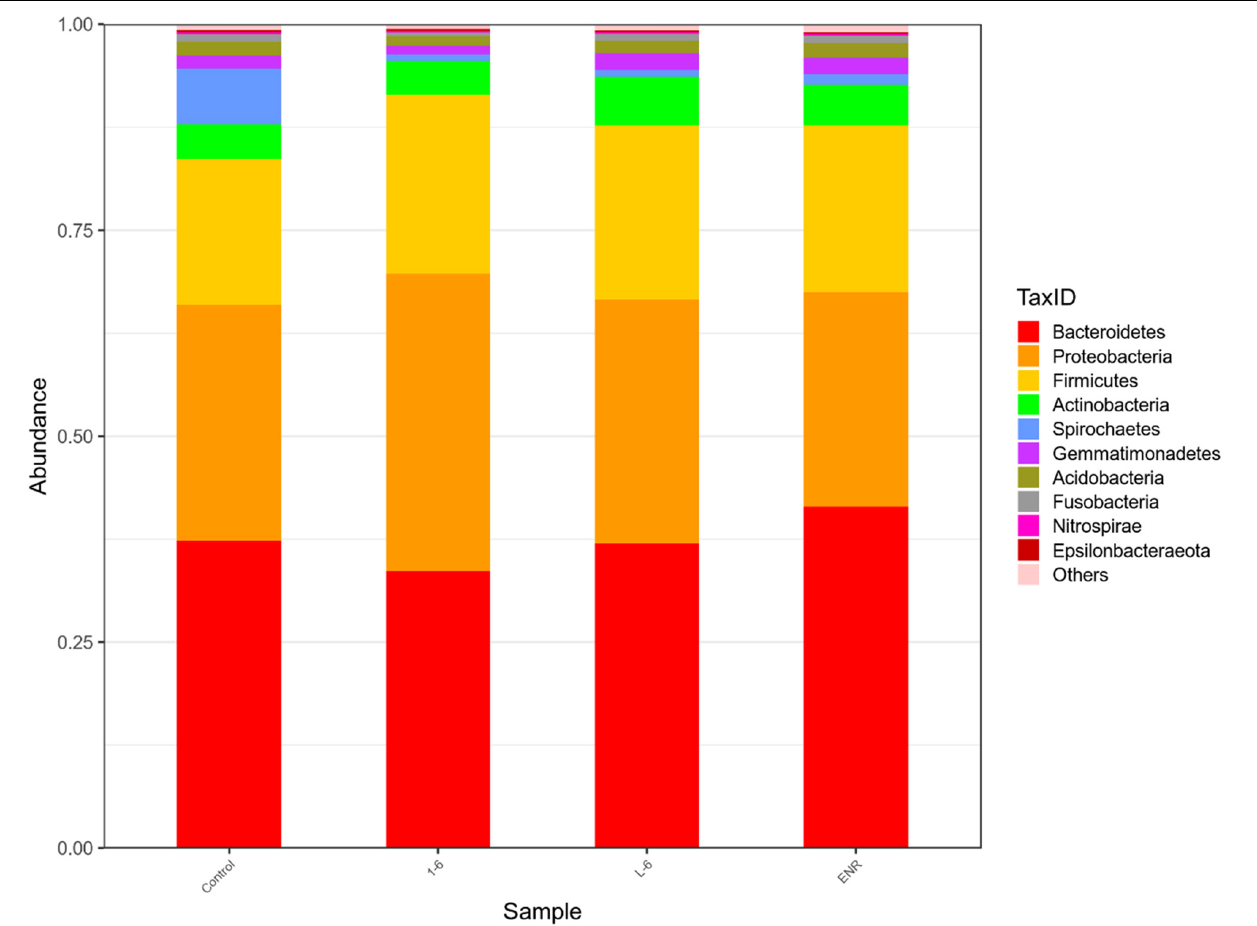
FIGURE 12 | Structure and composition of intestinal microflora of Sebastes schlegelii at phylum level. The relative abundance of Bacteroides and Proteobacteria in the control group was 37.24 and 28.53%, respectively. The relative abundance of Bacteroides and Proteobacteria in 1–6 group was 34.03 and 36.40%, respectively. The relative abundance of Bacteroides and Proteobacteria in L-6 group was 37.13 and 29.58%, respectively. The relative abundance of Bacteroides and Proteobacteria in enrofloxacin group was 41.47 and 25.97%,